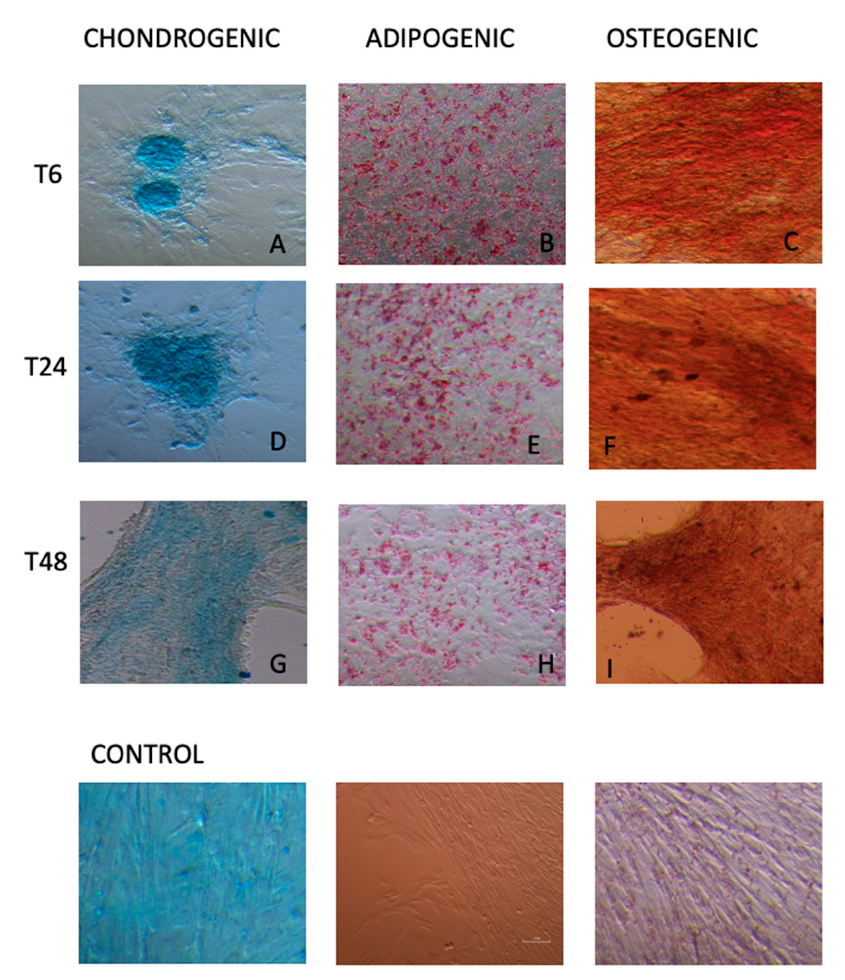
Figure 7. Stored eWJMSCs, cultured in induction medium for two weeks and stained for chondro- genic, adipogenic and osteogenic differentiation. T6: ( A ) cells stored in plasma at 4 °C; ( B ) cells stored in plasma at RT; ( C ) cells stored in saline solution at RT. T24: ( D ) cells stored in saline solution at 4 °C; ( E ) cells stored in plasma at 4 °C; ( F ) cells stored in plasma at RT. T48: ( G ) cells stored in saline solution at RT; ( H ) cells stored in saline solution at 4 °C; ( I ) cells stored in plasma at RT. Control groups are reported. Magnification 10×.